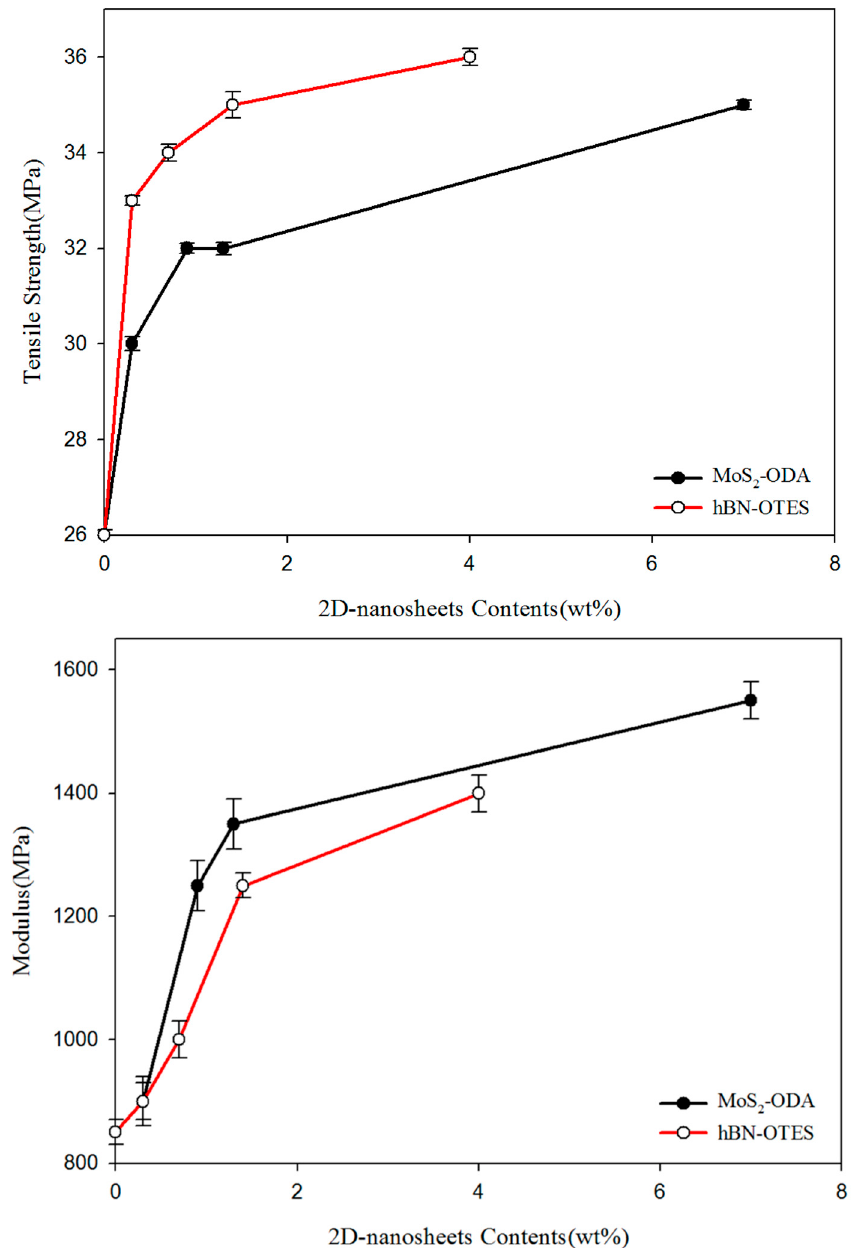
Figure 6. Effect of 2D-nanosheet contents on the tensile strength and Young’s modulus of PP/2D- nanosheets. Table 4. Mechanical properties of the PP/2D-nanosheet nanocomposites at various contents of 2D-